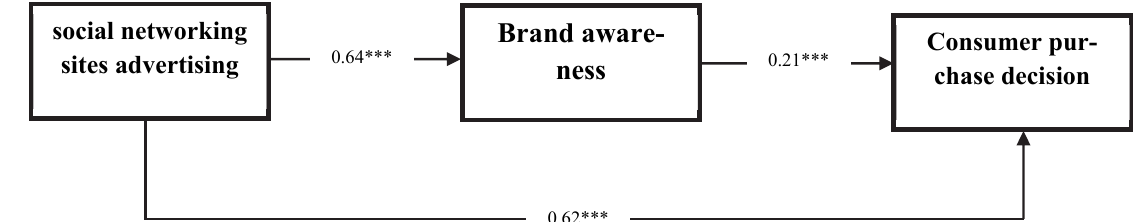
Fig. 2. Path model